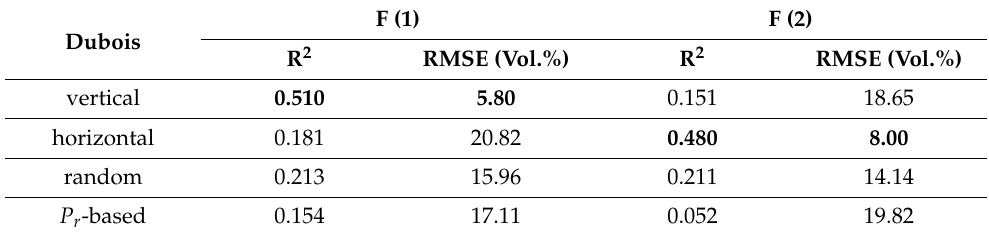
Table 4. Estimation results using Dubois model.